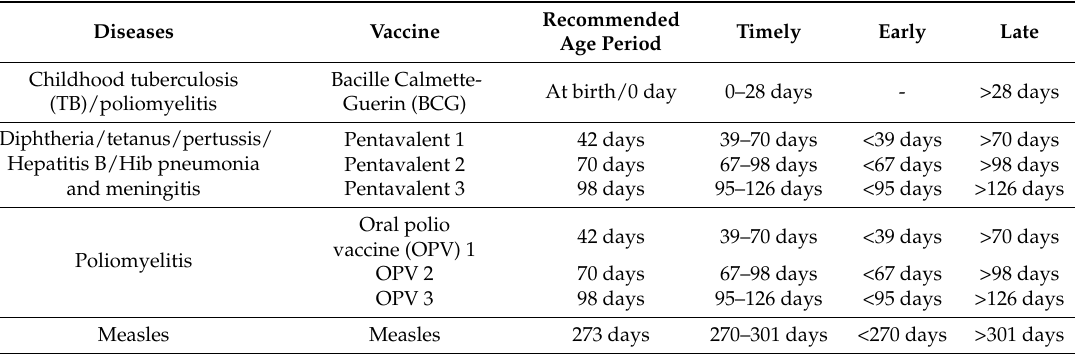
Table 1. The Expanded Program on Immunizations (EPI) schedule and timeliness in Bangladesh. Hib: Haemophilus influenzae type